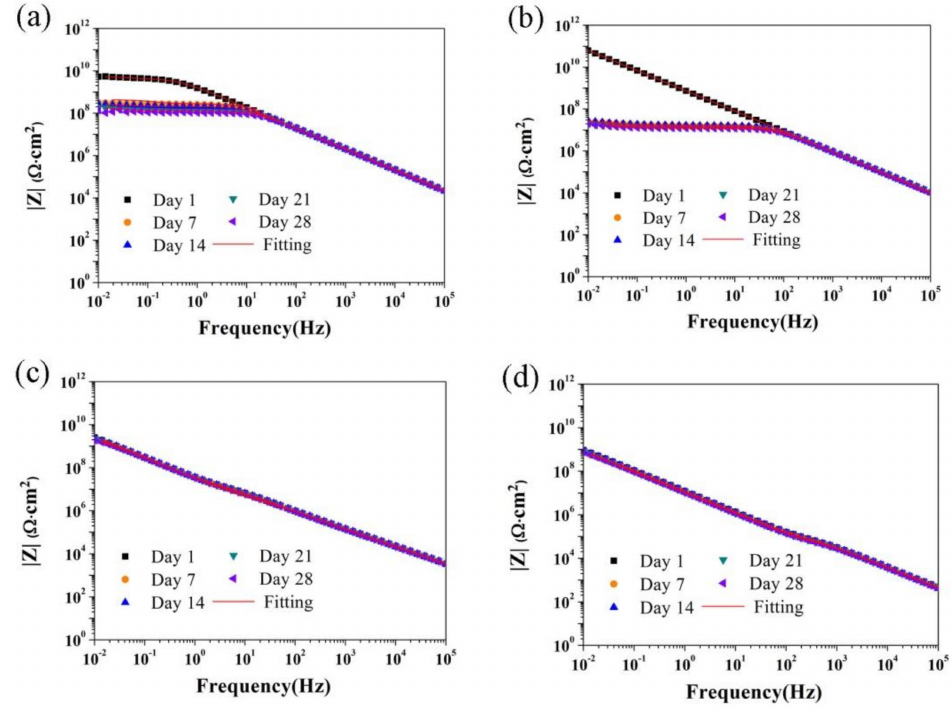
Figure 2. Bode plots of ( a ) PU, ( b ) PU2, ( c ) PU4 and ( d ) PU8 immersed in 3.5 wt.% NaCl solution for different